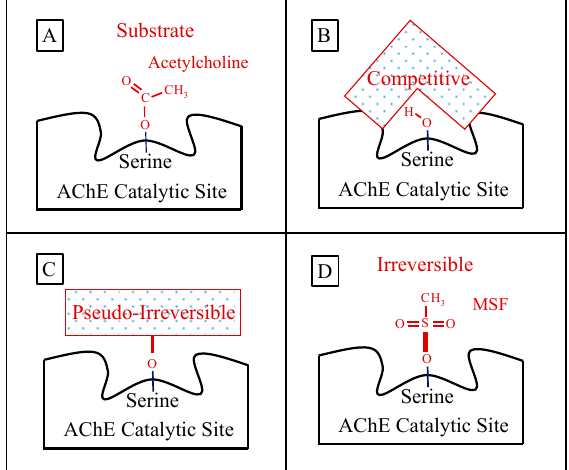
Figure 1. Panel ( A ) shows the normal ephemeral (microseconds) covalent acetyl-enzyme complex that is formed as an intermediate step in the hydrolysis of acetylcholine (shown). Panel ( B ) shows a schematic of a competitive inhibitor binding reversibly (spanning) the catalytic site representing donepezil or galantamine (note that the competitive inhibitor does NOT form a covalent bond with the serine sidechain OH required for acetylcholine hydrolysis). Panel ( C ) shows a longer-lasting covalent bond (signified by heavier red bars) formed between pseudo-irreversible inhibitors (spontaneously hydrolyzed with a half-time of hours) and the enzyme. The schematic box in Panel ( C ) represents the corresponding carbamoyl- or phosphoryl-enzyme covalent binding, respectively, for the case of rivastigmine, metrifonate, or DDVP, wherein the specific molecular structure of each pseudo-irreversible inhibitor intermediate not shown. Panel ( D ) shows an example of the irreversible sulfonyl-enzyme covalent complex (no spontaneous hydrolysis, no recovery) that permanently excludes acetylcholine binding and hydrolysis. The specific sulfonyl-enzyme covalent complex shown in Panel ( D ) is that formed during methanesulfonyl fluoride